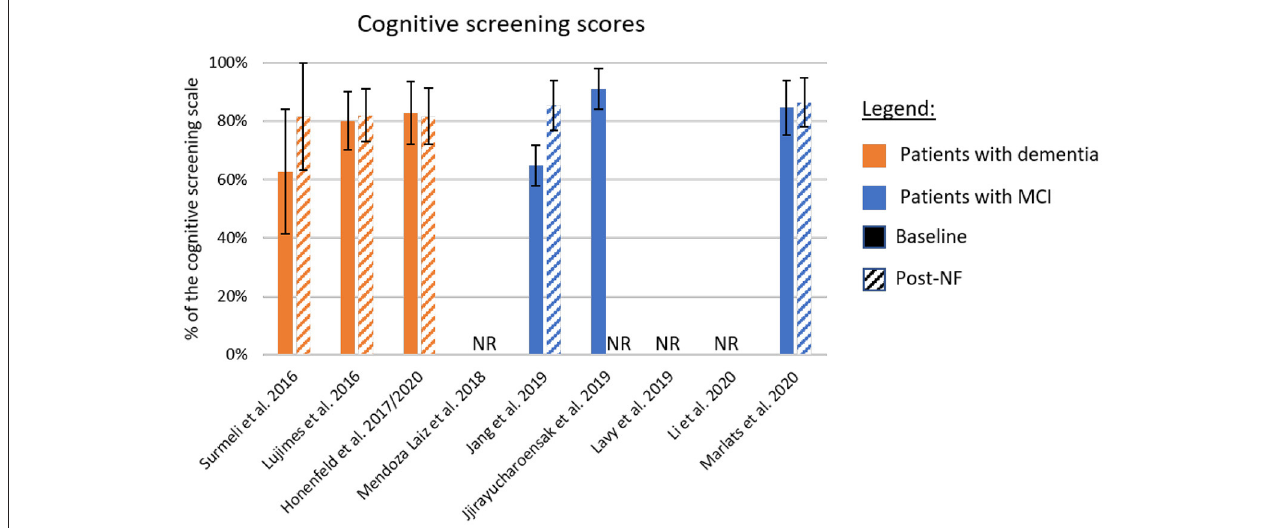
FIGURE 2 | Summary of cognitive improvement according to standardized cognitive screening scales. The baseline and post-neurofeedback measures normalized as a percentage of the respective scales. In orange are the studies using patients with formal diagnosis of dementia, and in blue patients with mild-cognitive impairment (MCI). If the study did not report a primary outcome, we adopted a conservative approach and included in this chart results from the scale showing lower improvement. Solid bars represent the baseline scores, and dashed lines the post-intervention values. NF, Neurofeedback; NR, Not